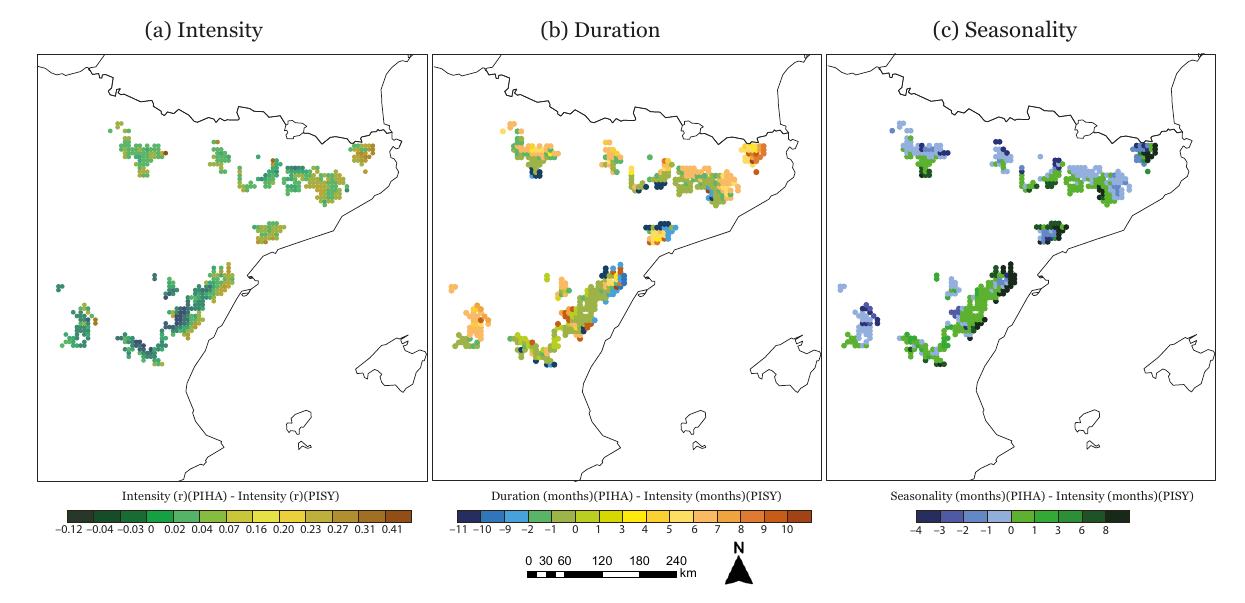
Figure 5. Differences in intensity ( a ), duration (in months) ( b ), and seasonality (in months) ( c ) between P. halepensis and P. sylvestris across coexistence distribution area. Positive values (or months) indicate that P. halepensis shows higher values (or months) than P. sylvestris .